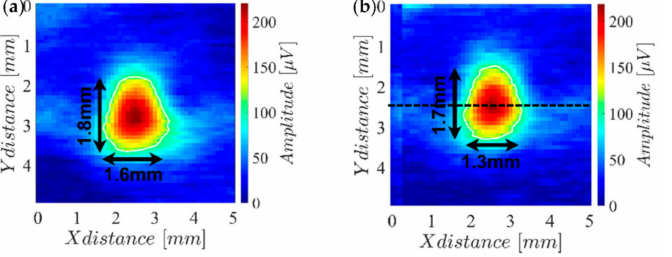
Figure 2. Amplitude imaging results measuring ( a ) coil 1 (22 µ H) and ( b ) coil 2 (68 µ H) while performing a two-dimensional scan over the reference hole of the LPBF-produced